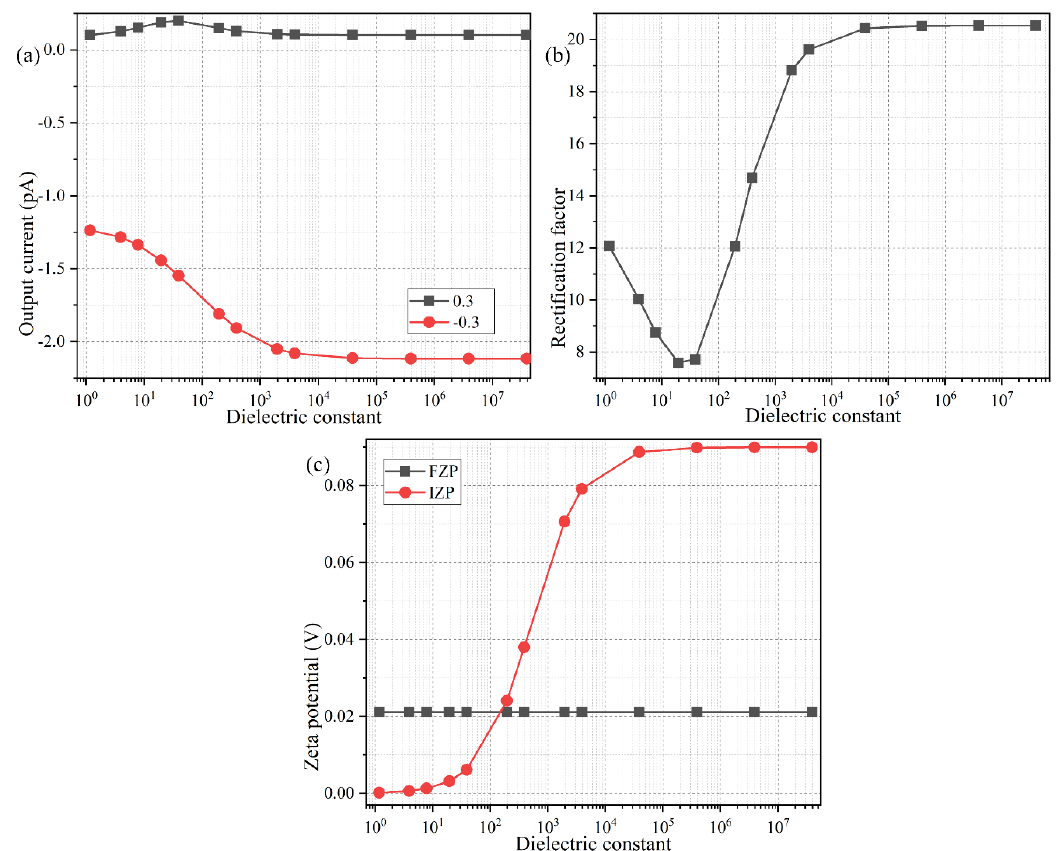
Figure 7. Effect of the relative dielectric constant of the conducting wall on the rectification behavior of the nanofluidic ion diode, under a given parametric space of V S = ±0.3 V, L C = 600 nm, σ free = -0.001 C/m 2 , c 0 = 0.1 mM, and R N = 15nm. ( a ) The forward and backward output electric current, and ( b )